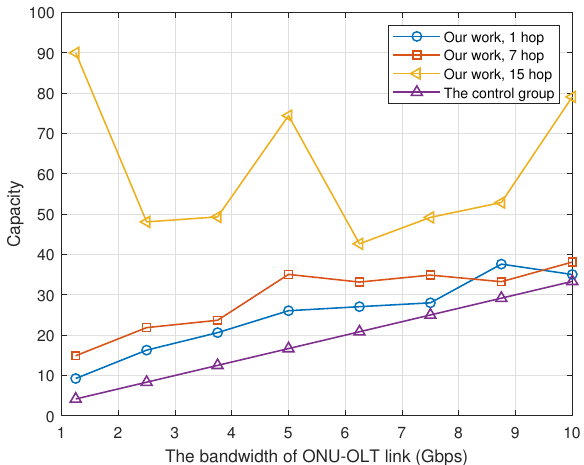
Figure 9. The capacity vs. the bandwidth of ONU-OLT